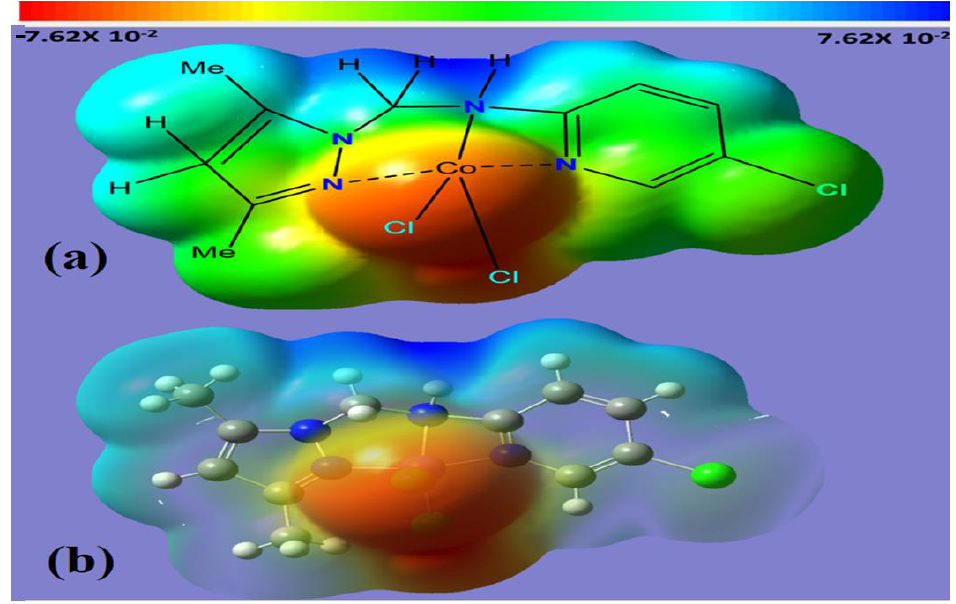
Figure 4. ( a ) Solid MEP and ( b ) transmit MEP.